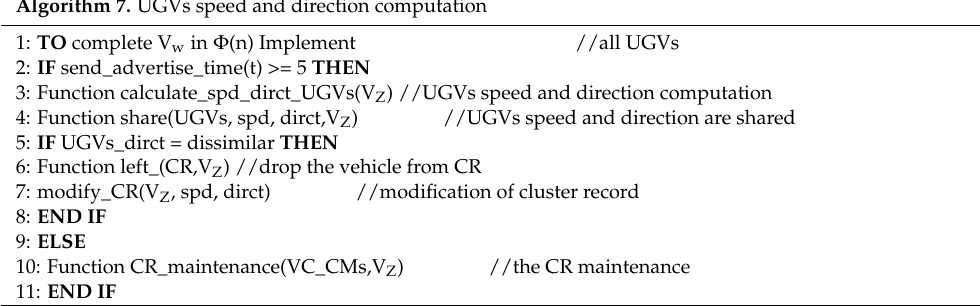
Algorithm 7. UGVs speed and direction